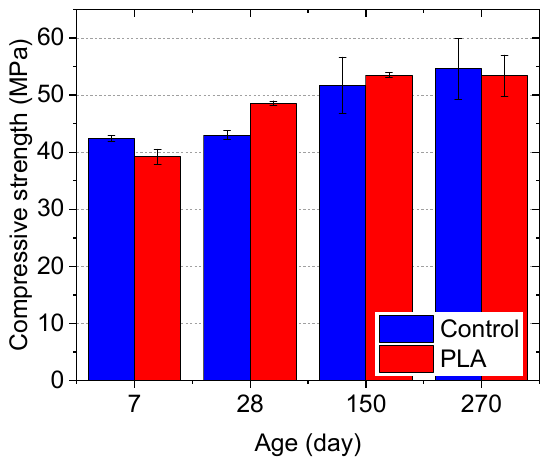
Figure 14. Comparison of compressive strength for mortar cubes with and without PLA capsules.